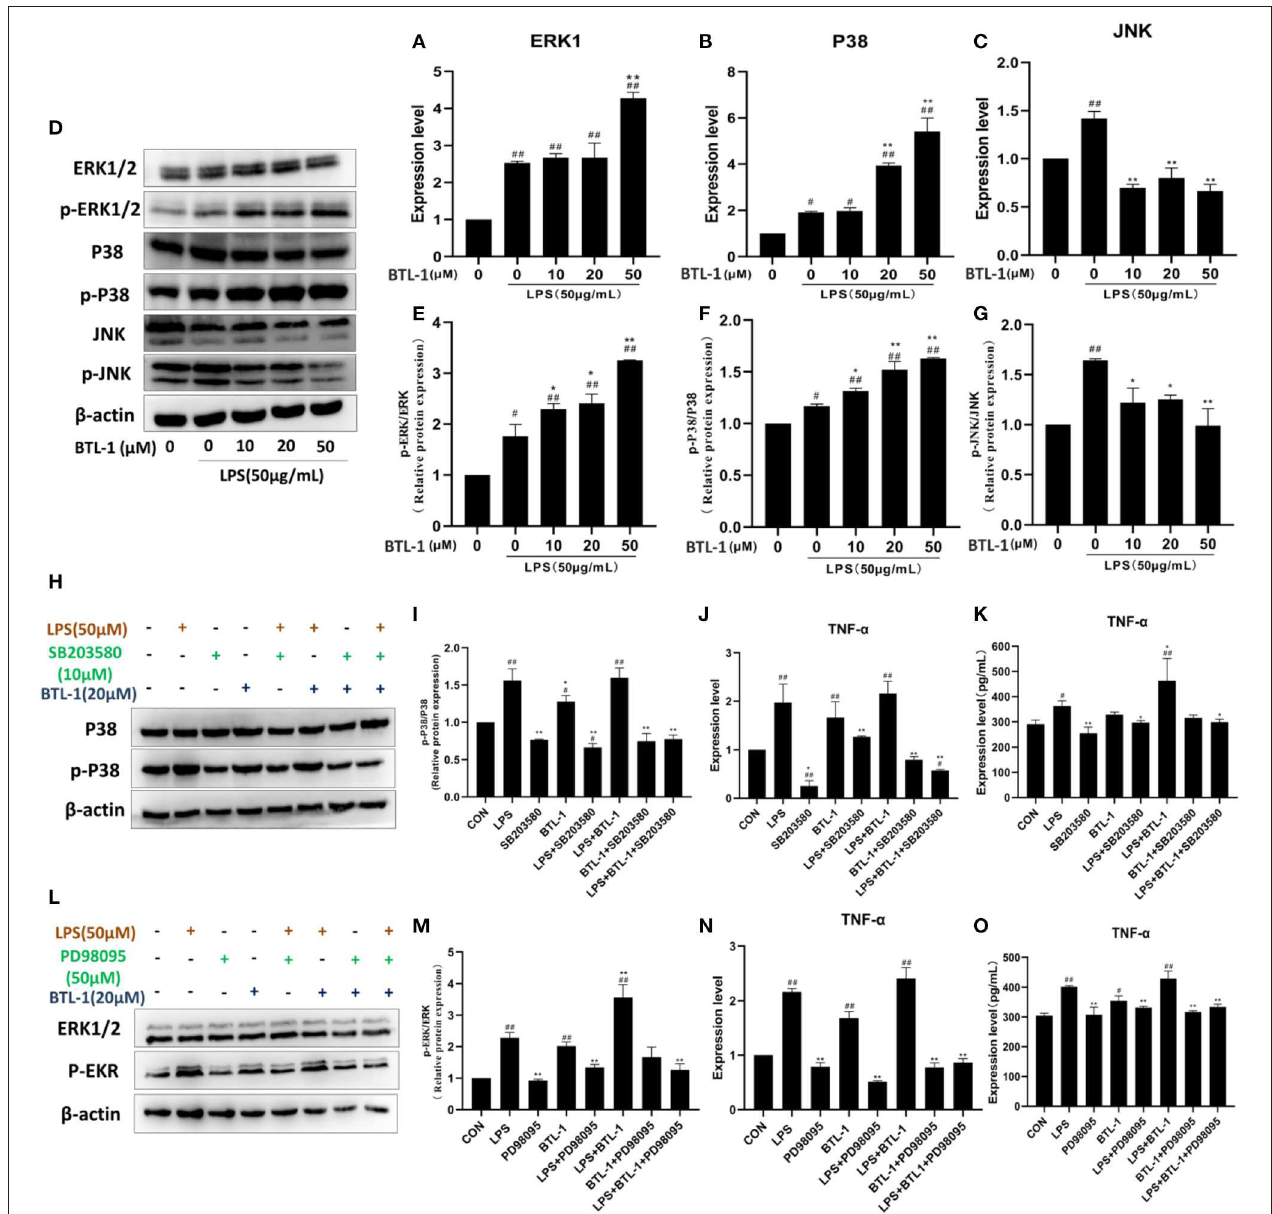
FIGURE 5 | Effect of BTL-1 on MAPK signaling pathway. The impact of BTL-1 on the MAPK signaling pathway determined by qPCR (A–C) . The outcome of BTL-1 on the MAPK signaling pathway determined by western blotting (D–G ). Effect of P38 inhibitor (SB203580, 10 µ M, 1h) on the phosphorylation of P38. (H,I) determined by western blotting. Impact of P38 inhibitor on the mRNA and protein of TNF- α determined by qPCR and ELISA. (J,K) . The outcome of ERK1/2 inhibitor (PD98095,50 µ M, 1h) on the phosphorylation of ERK1/2 (L,M) determined by western blotting analysis. Inhibitory effect of ERK1/2 inhibitor on the mRNA and protein of TNF- α determined by qPCR and ELISA (N,O) . The data shown are representative of three independent experiments. The inhibitors of ERK1/2 and P38 were added 1h before LPS and BTL-1 treatment, and the cells were washed with PBS three times before adding LPS and BTL-1. The results were expressed as the means ± SEM. # P < 0.05, ## P < 0.01, compared to non-treated group, * P < 0.05, ** P < 0.01 compared to LPS group.